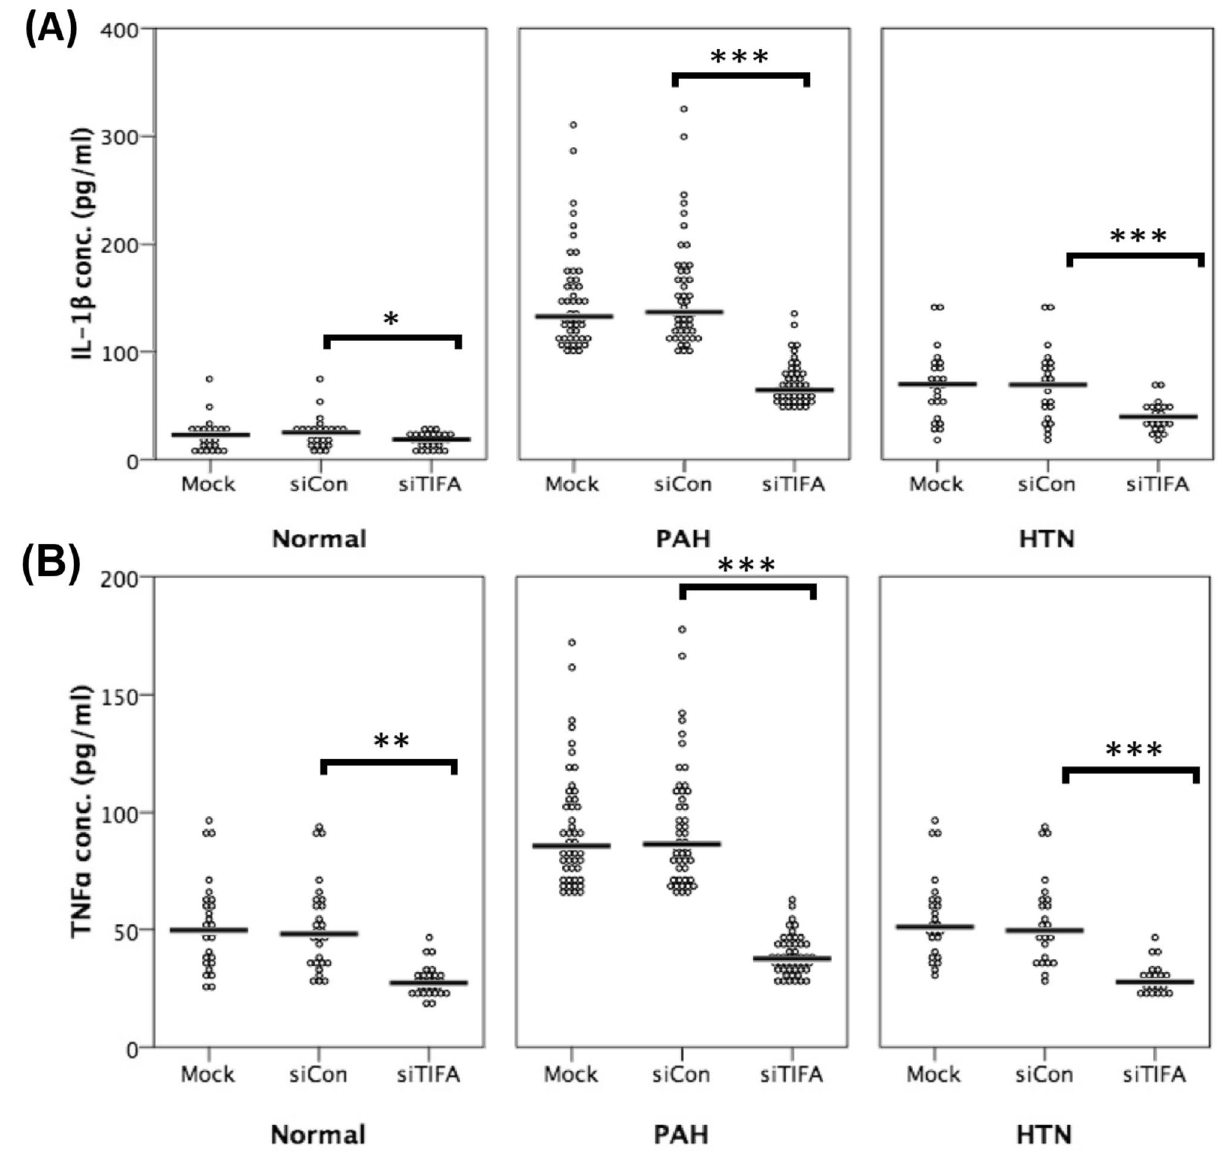
Figure 3. Silencing of TIFA protein expression leads to decreased secretions of ( A ) TNF-α and ( B ) IL-1β in cultured peripheral blood mononuclear cells from patients with pulmonary arterial hypertension (PAH) and systemic hypertension (HTN). * P < 0.05; ** P < 0.01; *** P < 0.001. IL-1β = interleukin-1β; siCon = control siRNA; siTIFA = TIFA siRNA; TIFA = tumor necrosis factor-α receptor-associated factor-interacting protein with a forkhead-associated domain; TNF-α = tumor necrosis